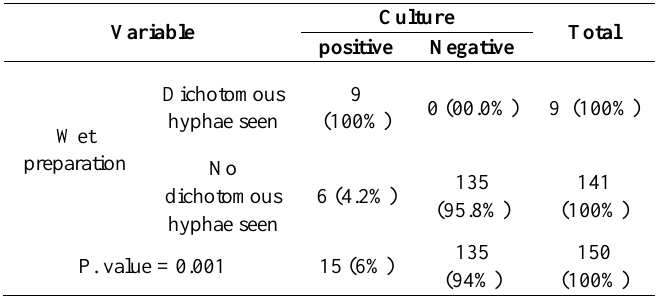
Table 1: Comparison between the results of direct microscopy and